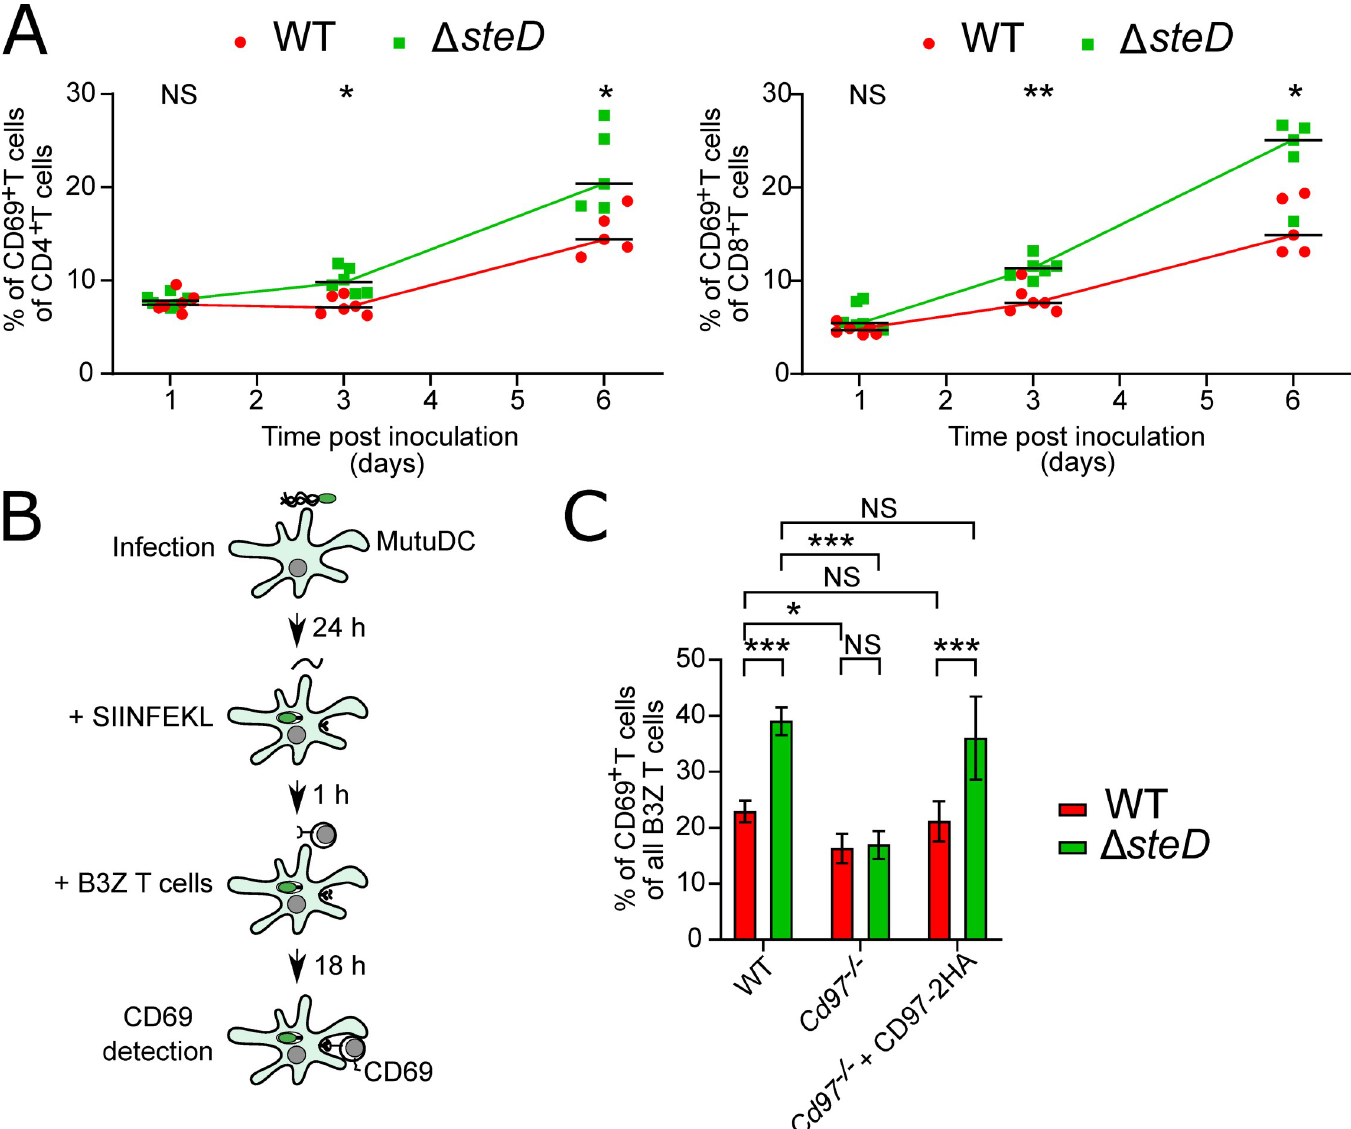
Fig 5. SteD interferes with CD97-dependent activation of T cells. (A) Quantification of CD69 + CD4 + and CD69 + CD8 + T cells in infected mice. Cells were isolated from draining MLNs of C57BL/6 mice inoculated orally with the indicated S . Typhimurium strains at indicated times post-inoculation. Amounts of CD69 + T cells are expressed as percentage of all CD11c - CD3 + CD4 + or CD11c - CD3 + CD8 + cells. Each dot represents the value obtained from MLNs pooled from two or three mice from three independent experiments and means ± SD are shown. � p < 0.05, �� p < 0.01, NS—not significant (two-way ANOVA followed by Tukey’s multiple comparison test). (B) Schematic of in vitro SIINFEKL (OVA)-dependent B3Z T cell activation assay. MutuDCs infected with GFP-expressing S . Typhimurium were exposed to SIINFEKL (ovalbumin-derived peptide for MHCI presentation). After 1 h, CD8 + B3Z T cells were added and co-incubated for 18 h prior to measurement of CD69 on B3Z T cells by flow cytometry. (C) In vitro SIINFEKL (OVA)-dependent B3Z T cell activation assay. WT, Cd97 -/- or Cd97 -/- + CD97-2HA MutuDCs were infected with WT-GFP or Δ steD -GFP S . Typhimurium and exposed to SIINFEKL peptide. Percentage of CD69 + B3Z T cells in each condition is shown. Data are from 3 independent experiments and show means ± SD. � p < 0.05, ��� p < 0.001, NS–not significant (two-way ANOVA followed by Tukey’s multiple comparison